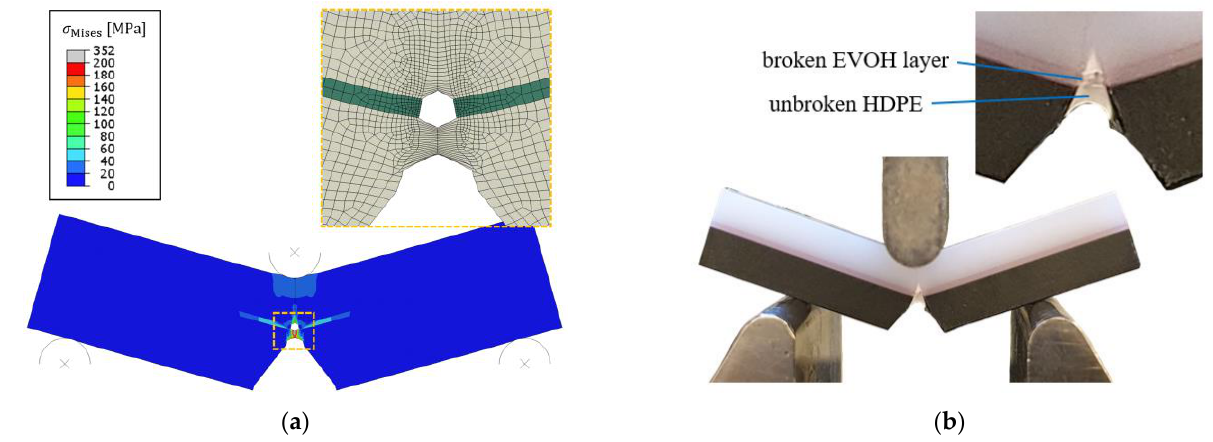
Figure 8. ( a ) Mises stress field (MPa) in the FEA model of the layered SENB specimen for a displacement load u y of 4.5 mm and an HDPE fracture toughness of 12,000 J/m 2 , and ( b ) the specimen’s deformation and crack propagation in the experiment for u y = 6 mm. The initial crack tip is blunted, and a crack has initiated in the EVOH layer that has slightly grown into the HDPE material.